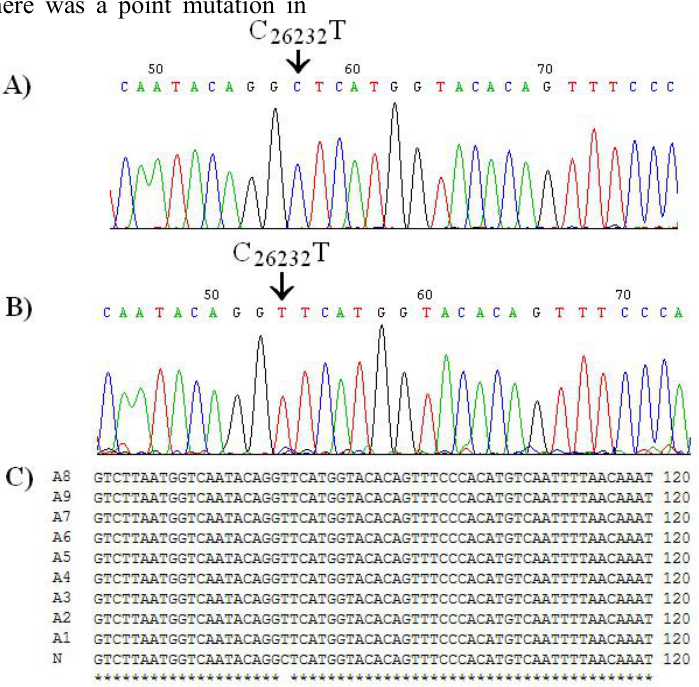
Fig. 5. Direct sequencing of exon7 of the Nsun7 gene in asthenoteratospermic men: (A), The wild type sequence showing ‘C’ at the nucleotide position 26232 in the Nsun7 gene; (B), Sequence of a asthenoteratospermic infertile men with poor motility showing mutant allele ‘T’, which was observed in a total of 20 asthenoteratospermic infertile men; (C), Blast analysis of the exon7 sequences in all A= asthenoteratospermic and N= Normospermic